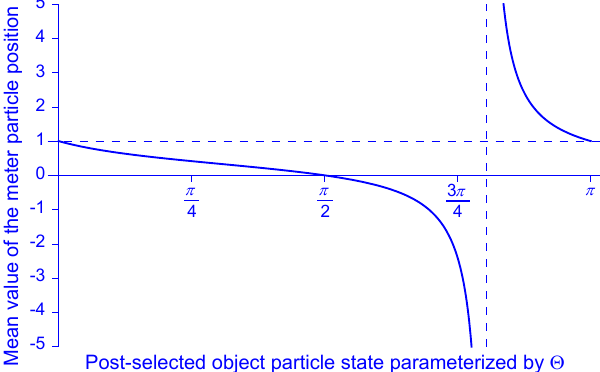
Figure 3: Mean values of the meter particle position for di ff erent post-selected states of the object particle parame- terized by the parameter Θ . The plot is discontinuous at (cid:18) (cid:19) Θ = π − arctan 1 √ , for which the post-selected | f ( Θ ) (cid:105) is 2 orthogonal to the pre-selected | s (cid:105) , hence no ordinary weak value is